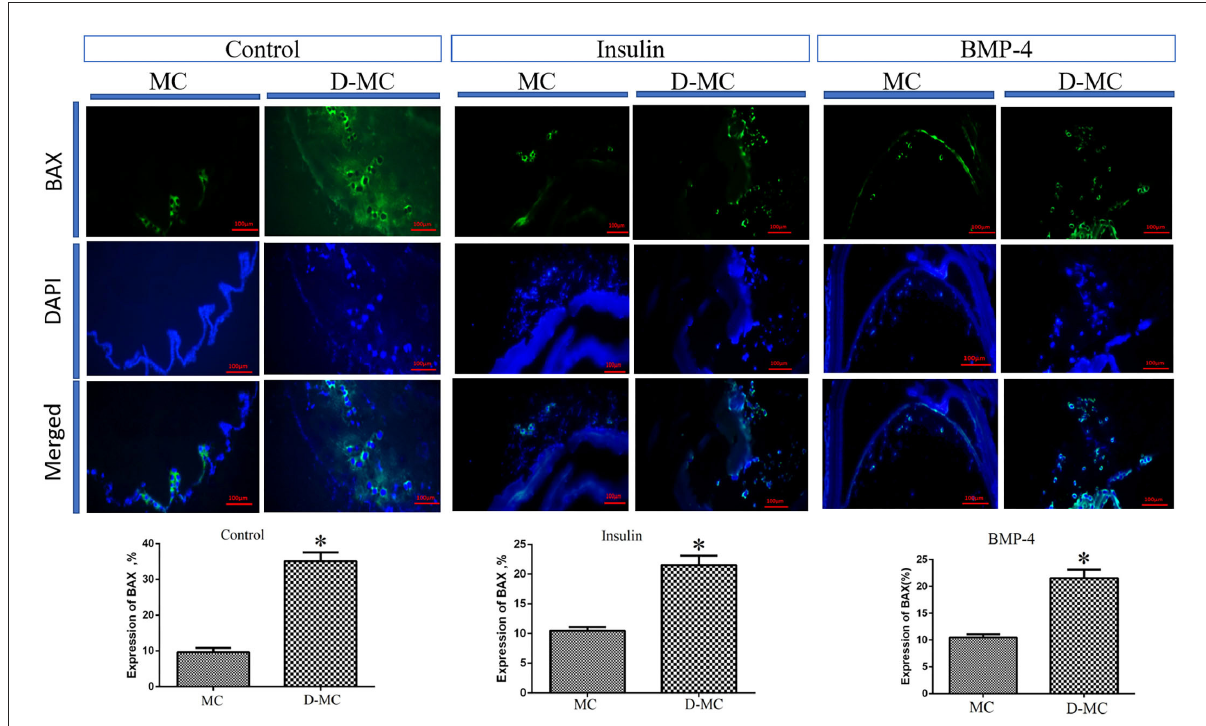
FIGURE4 BAX expression changes in microcysts of Echinococcus granulosus treated in vitro with insulin and BMP-4 compared to the control, immunohistochemistry staining. MC, Microcyst; D-MC, Deformed Microcyst. (* P < 0.05).